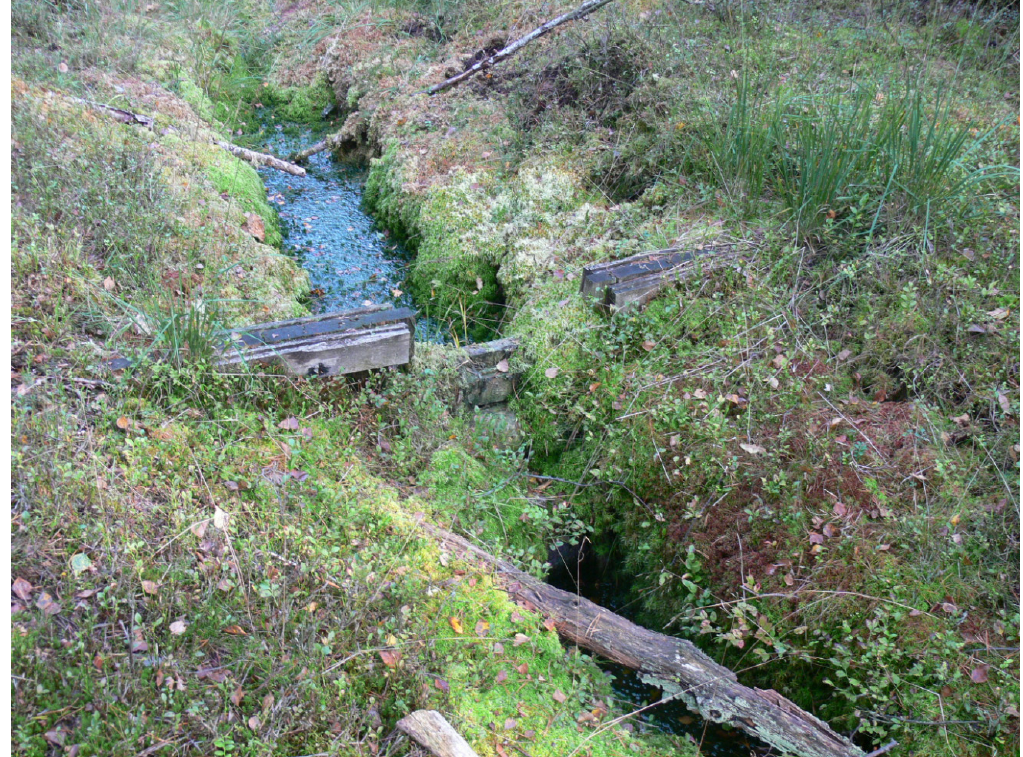
Figure 6. A water gate and overgrown drainage ditch at the border of forest section 310i in Bagno Kusowo.